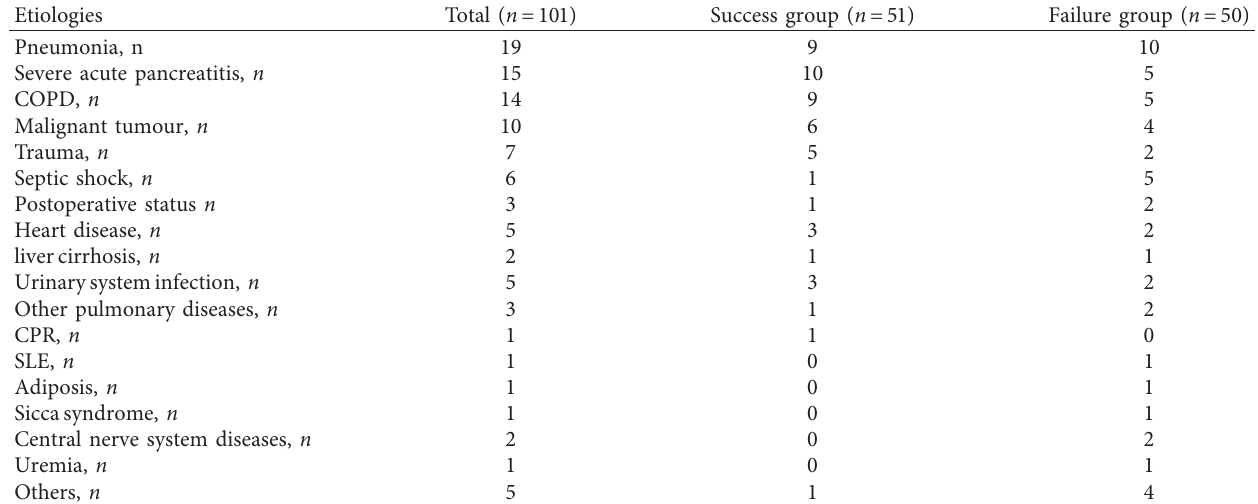
Table 1: Etiologies of patients who were admitted to our ICU and received